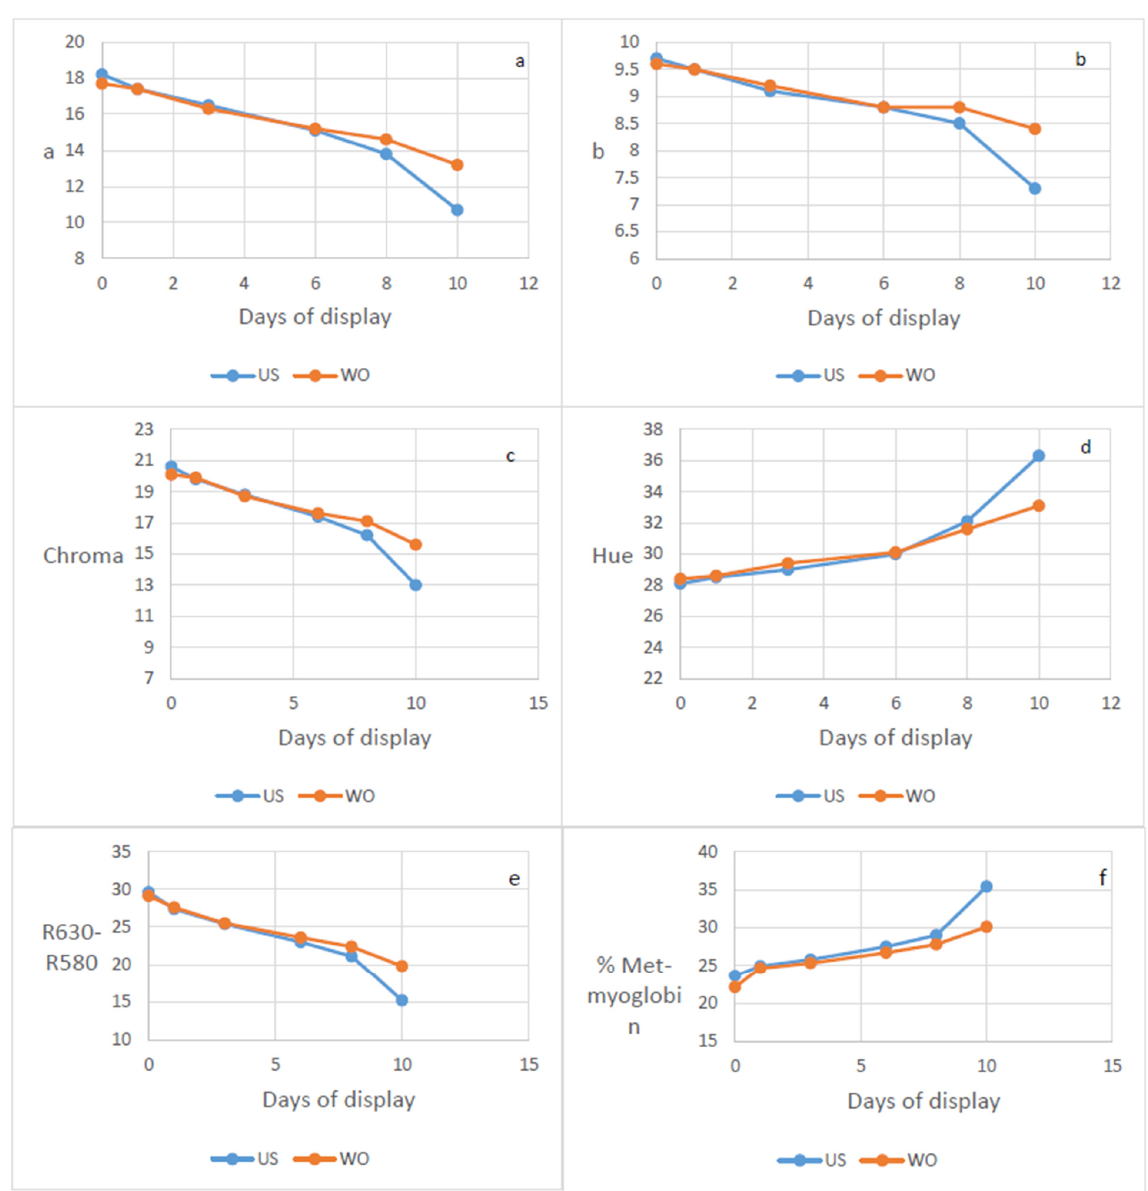
Figure 1. Redness ( a ), yellowness ( b ), chroma ( c ), hue ( d ), reflectance difference ( e ) and % metmyoglobin ( f ) during retail display of longissimus muscle from beef heifers offered either an unwilted grass silage and a barley/soyabean concentrate (US) or wilted grass silage and a concentrate containing sunflower oil and fish oil (WO) ration during the winter prior to finishing at pasture. Table 6. Sensory characteristics of longissimus muscle of beef heifers.